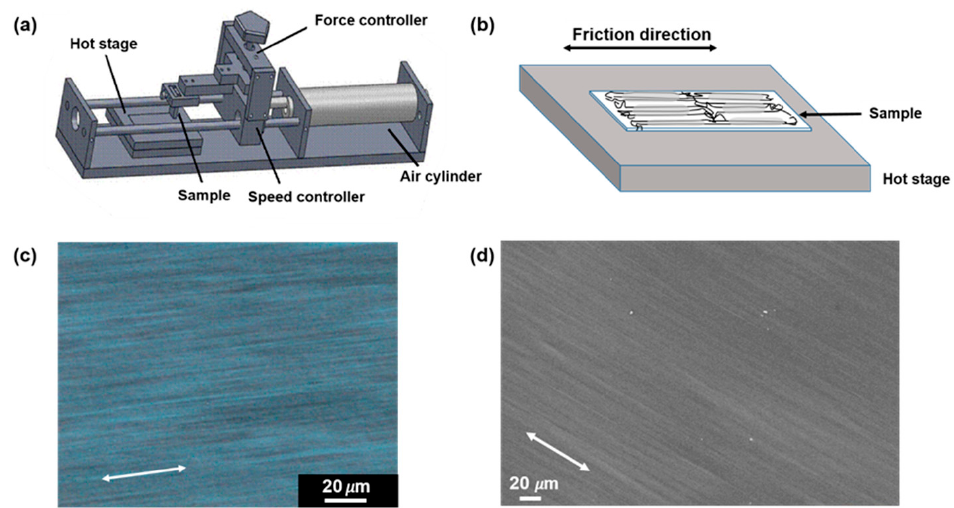
Figure 1. Schematic drawing of homemade mini friction transfer machine ( a ); enlarged region for the PLLA chain axis on the glass slide along the friction direction ( b ); POM ( c ) and SEM ( d ) images of the PLLA films friction transferred at a temperature of 100 ◦ C, respectively. The arrows indicate the friction